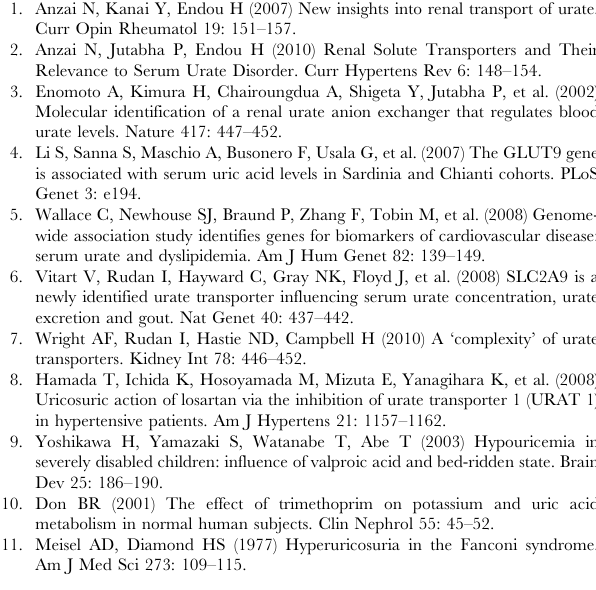
Table S1 Oligonucleotide primers for exon PCR of SLC22A12 and SLC2A9. Table S2 Oligonucleotide primer pairs used for site-directed mutagenesis of